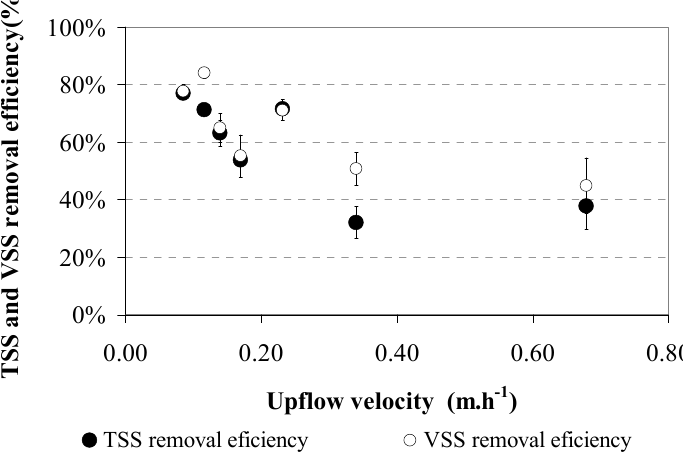
Figure 9. TSS ( ● ) and VSS ( ○ ) removal efficiencies in the control experiment—No sludge bed. Results show the average of three samples and standard